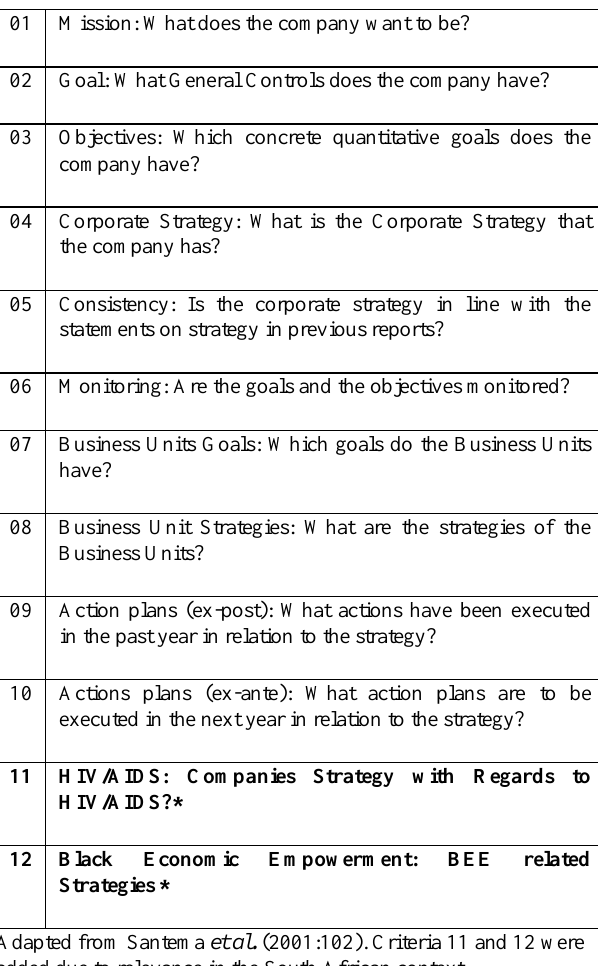
Table 1: Strategy disclosure